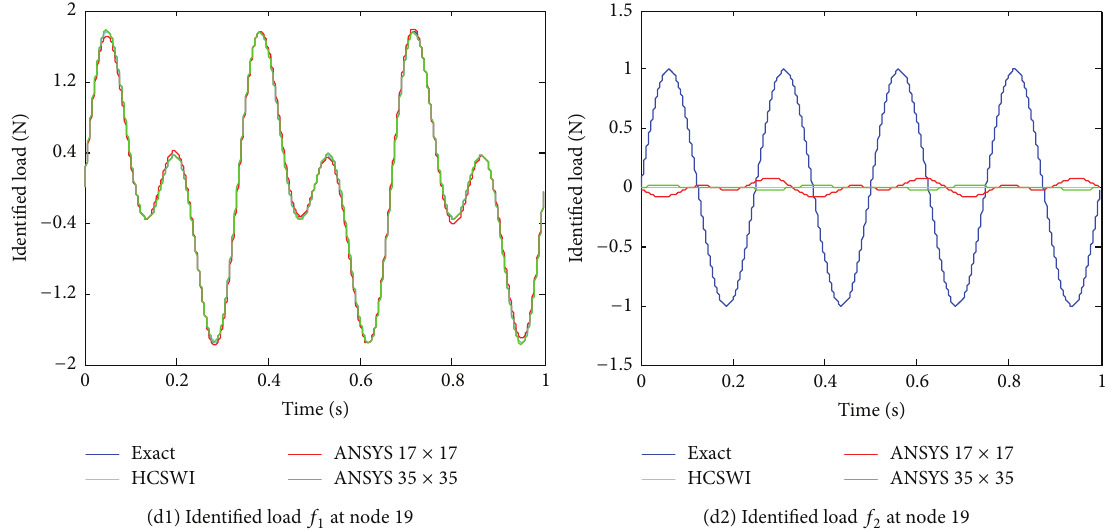
Figure 13: Load identification at different nodes with excitation 𝑓 1 and excitation 𝑓 2 applied at nodes 1 and